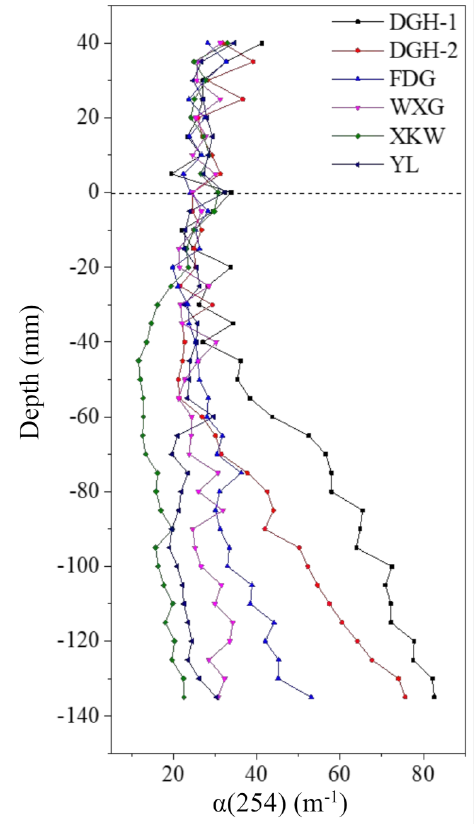
Figure 4. Vertical distribution of UV-Vis spectroscopy absorption coefficient α (254) of sediment pore water in sampling sites. Dashed lines indicated approximated positions of sediment–water interface